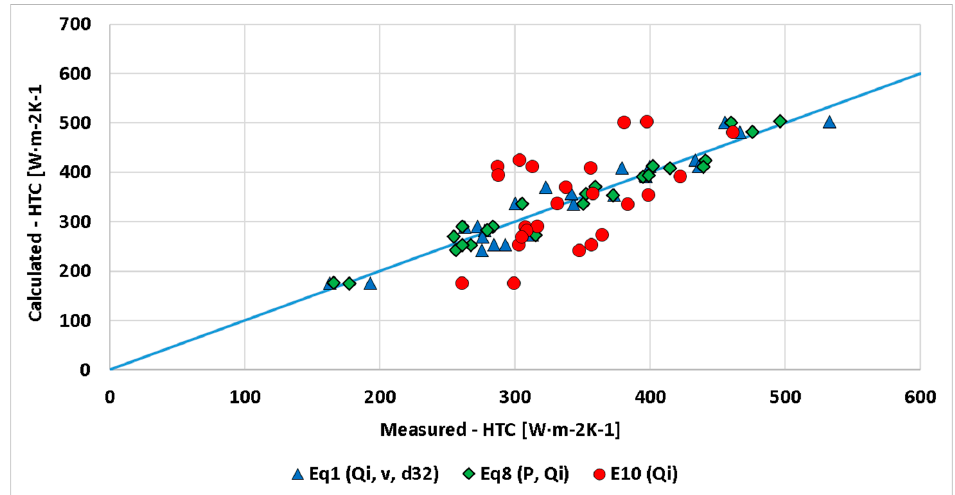
Figure 15. Correlation between measured HTC and calculated HTC for three selected equations.